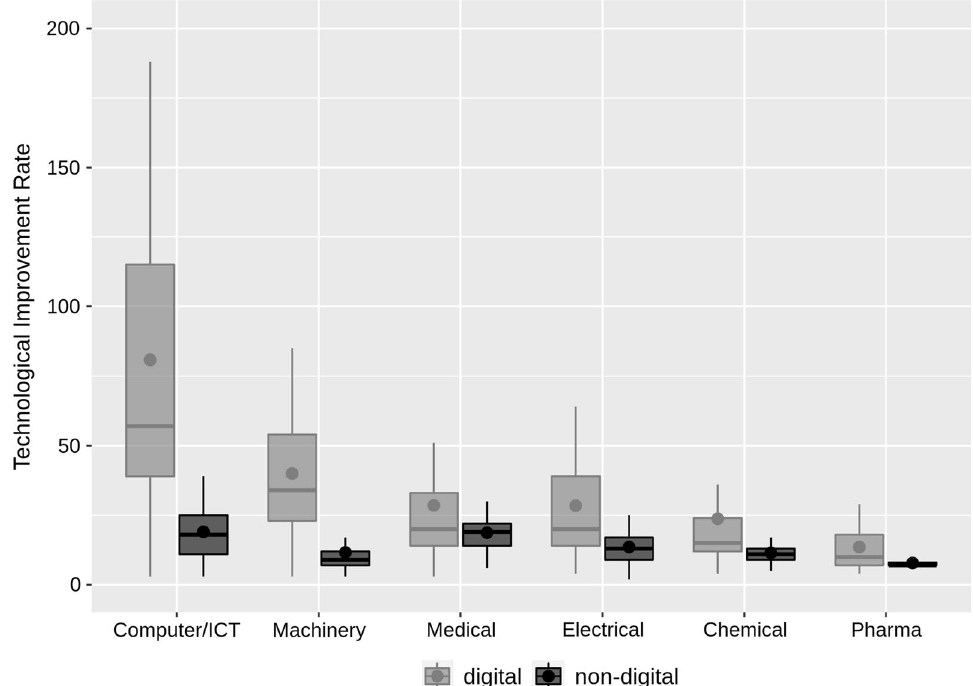
Fig. 2 Technological improvement rates of digital and non-digital technologies across industries. Notes: 1757 different improvement rates from Singh et al. (2021) are assigned to USPTO patents of the filing years 2010–2015. This results in a total of 283’431 USPTO patents. Patents are then split into the digital or non-digital group based on the approach proposed by Inaba and Squicciarini (2017) and assigned to industries according to De Rassenfosse et al. (2014). The horizontal line shows the median, the big dot the mean, the upper limit of the box the 25th, and the lower limit the 75th percentile. The length of the whisker shows the data that are within 1.5 times the interquartile range. Compared to Fig. 1, we do not show outliers to increase